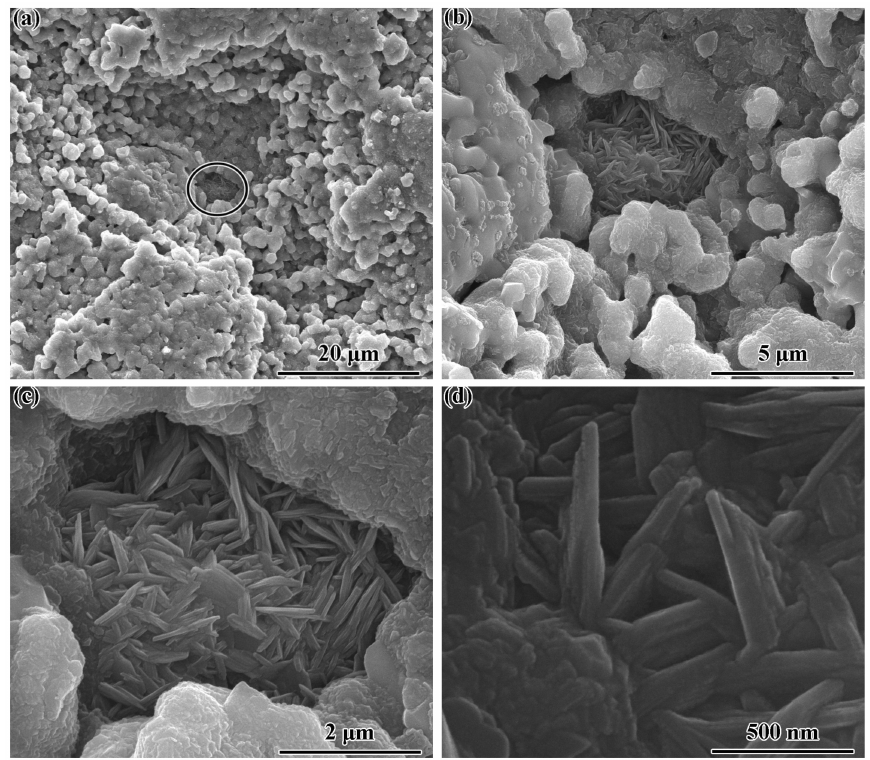
Figure 4. Morphologies of the surface of the preoxidised coating in the as-received state under different magnifications: ( a ) 5000 × ; ( b ) 20,000 × ; ( c ) 50,000 × ; ( d ) 200,000 ×